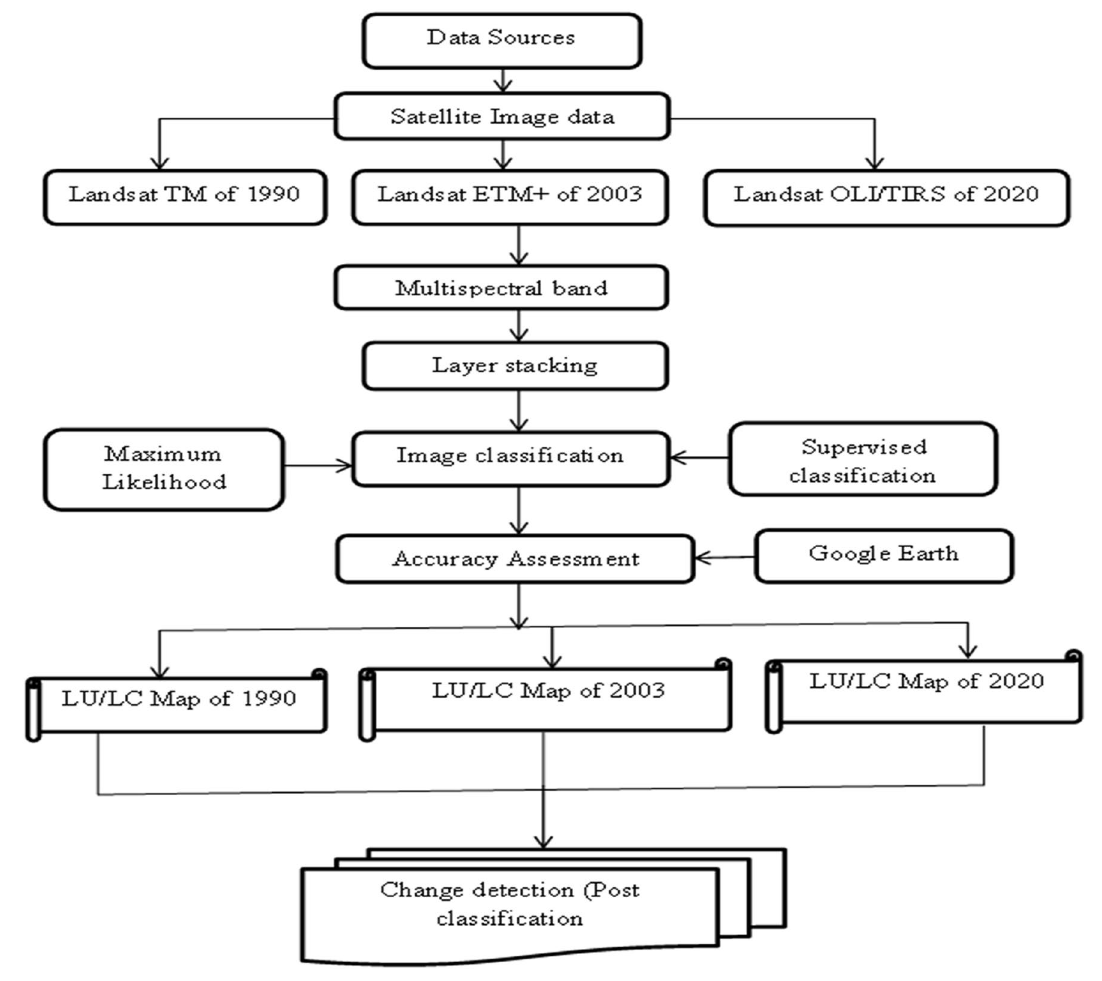
Fig. 2 Methodological flowchart for the determination of LULC change